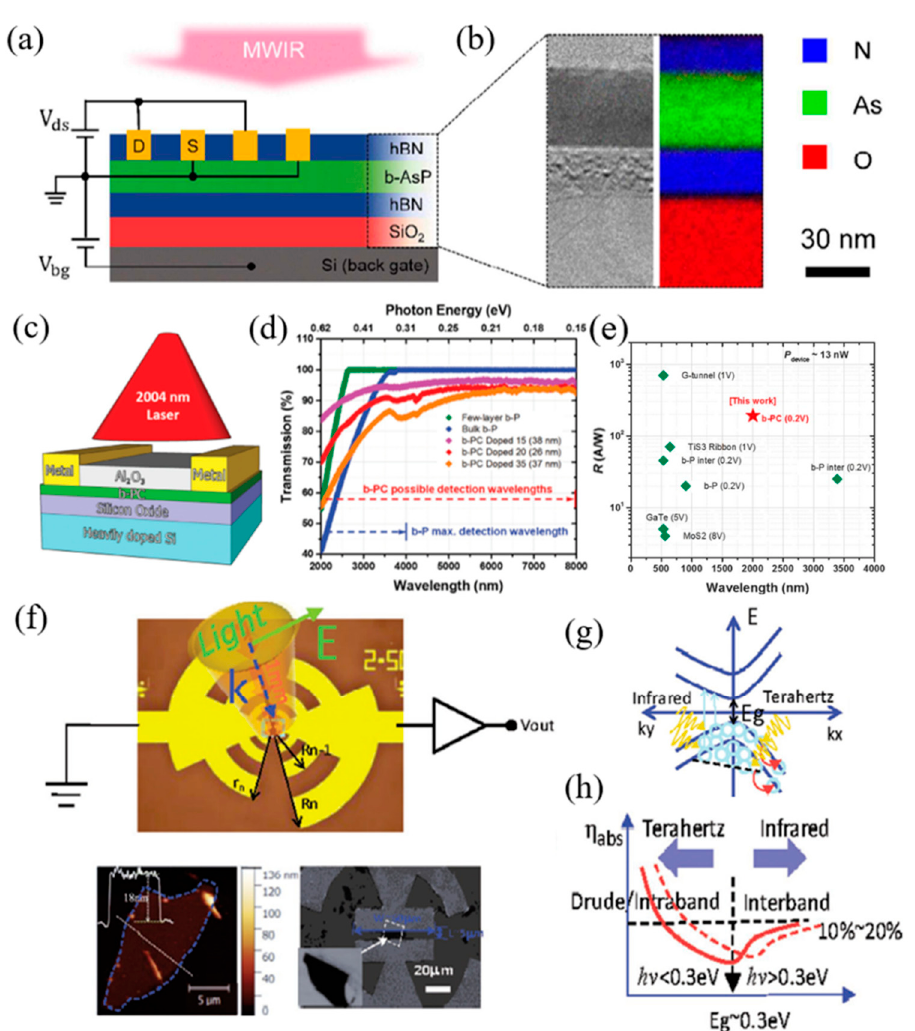
Figure 23. ( a ) Section diagram of the as-fabricated hBN/b-As 0.83 P 0.17 /hBN heterostructure PD. ( b ) Cross section TEM image (Left) and element analysis diagram (right) of the device [100]. ( c ) Schematic diagram of the b-PC phototransistor. ( d ) The AFM of the b-PC phototransistor. ( e ) The response capacity of b-PC is compared to photodetectors reported in recent years measured at the same incident power on the active region [311]. Copyright 2017 Wiley-Blackwell. ( f ) Antenna in- tegrated BP photoconductor. ( g ) The interaction of incident infrared and terahertz photons results in the electron–hole transition of BP slices. ( h ) The boundary between free hole absorption and the generation of inter-band electron-hole pairs is marked by an absorption spectral profile